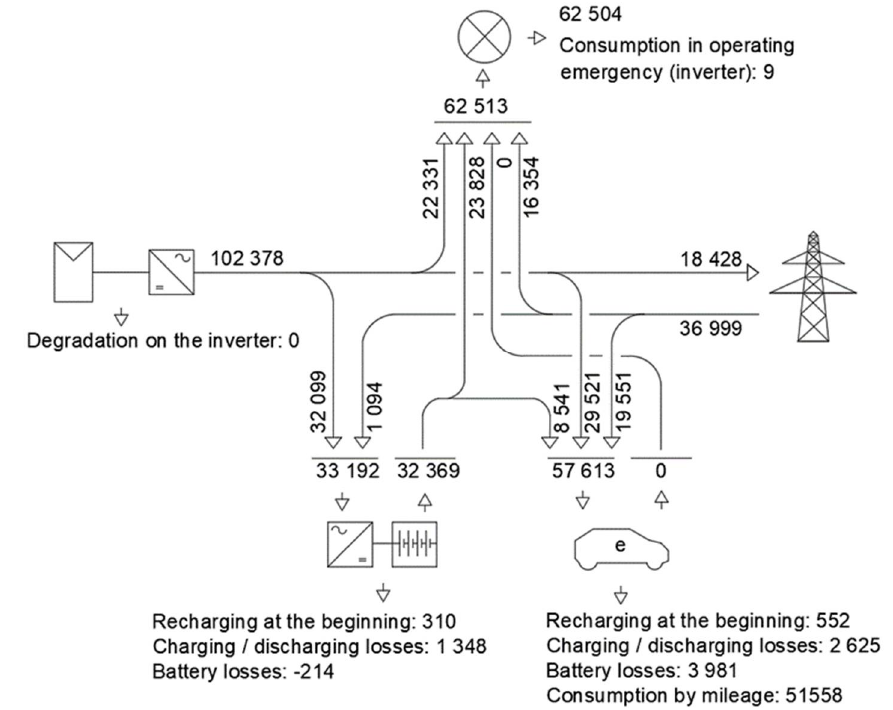
Figure 19. Energy flow from the photovoltaic power plant of Block A.